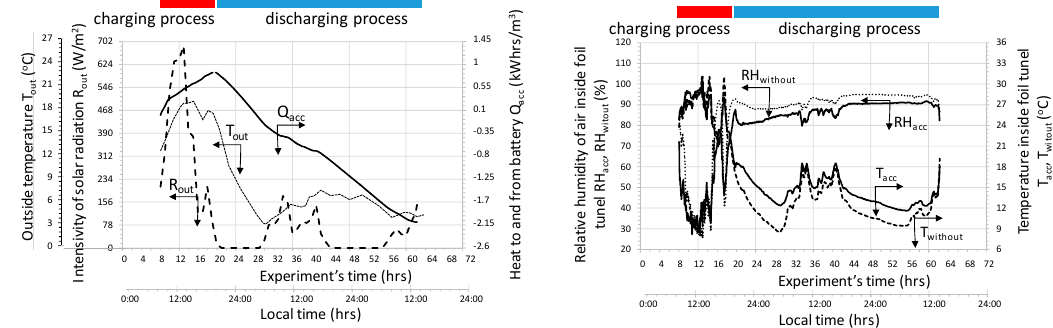
Figure 9. The course of measured and calculated parameters during a full cycle of charging and discharging the stone-bed accumulator.